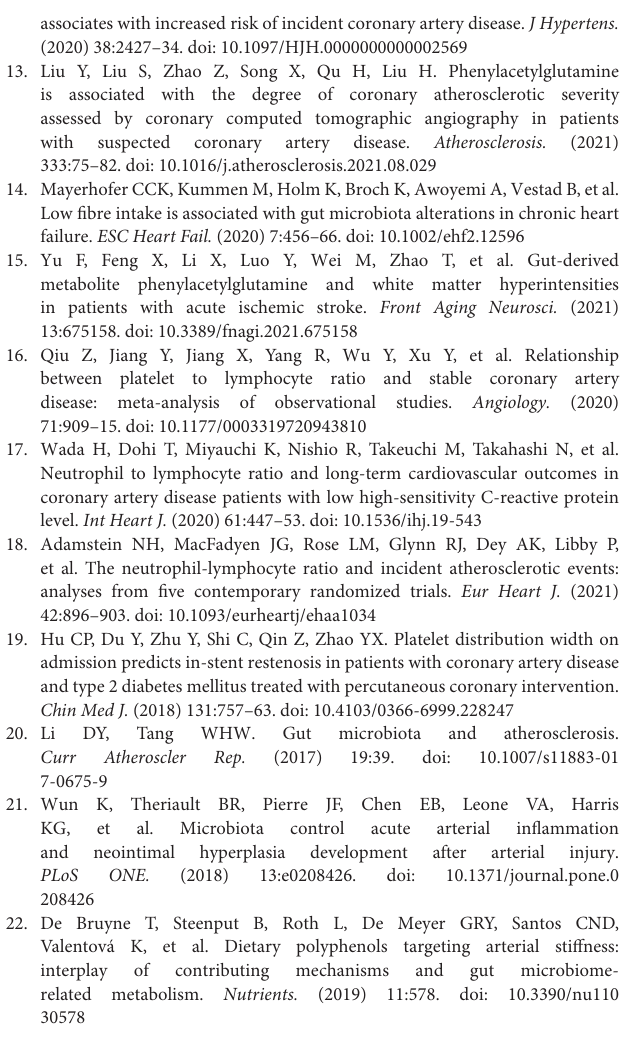
Supplementary Table S1 | The model and score of PAGln-related KO Score. Supplementary Table S2 | Baseline clinical characteristics of participants in the study of plasma PAGln. Supplementary Figure S1 | Detailed information of ANOSIM, envfit and random forest analysis. Supplementary Figure S2 | Detailed information of LASSO analysis and correlation between PLR and hisC as well as Chao